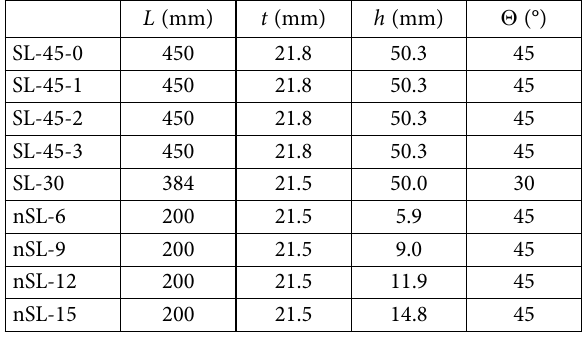
Table 4. Dimensions of the knee braces in the specimens of retrofiteed steel frames